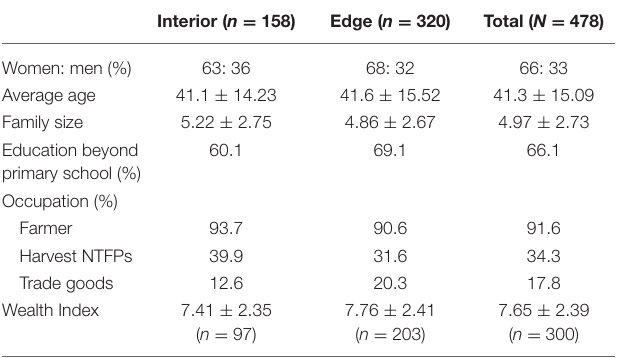
TABLE 1 | Sociodemographic characteristics of respondents.